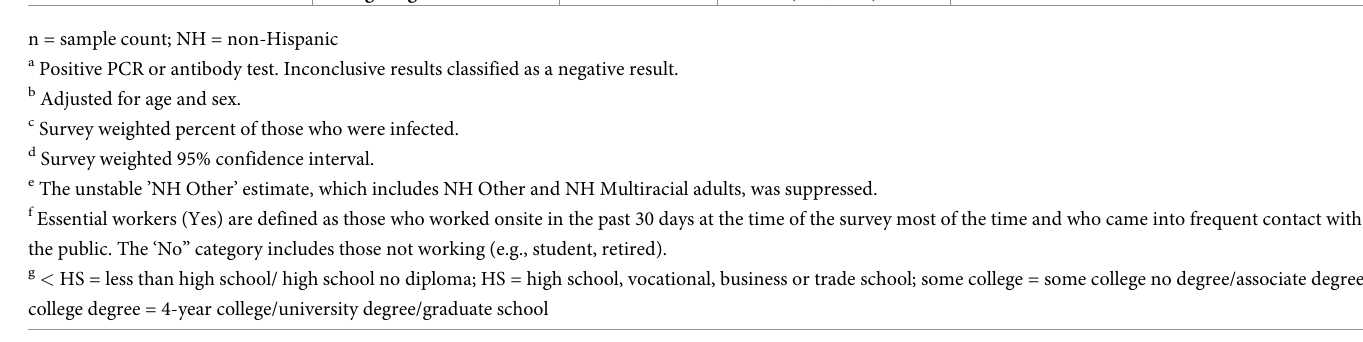
Fig 2 describe adoption of CDC recommendations to prevent infection: Limiting social gath- erings, staying home unless necessary, keeping at least a 6-foot “social distance” away from those not residing in their household, and wearing a mask outside the home. In general, a higher proportion of women practiced recommended behaviors than men. Except for mask wearing, a lower proportion of young adults practiced recommended behaviors.